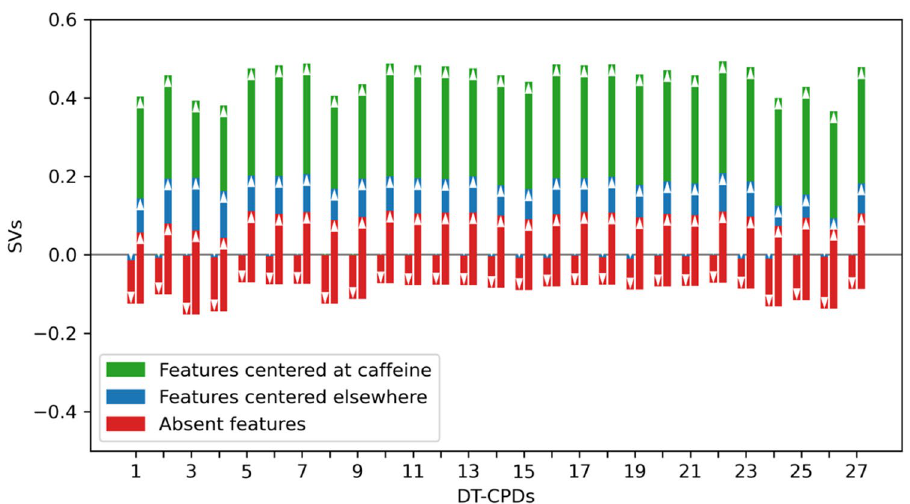
Figure 7. Contributions of caffeine-delineating features and others. For caffeine-containing DT-CPDs, cumulative SV contributions of features defining the caffeine moiety (green), features mapping elsewhere in the compound (blue), and absent features (red) are reported. The height of each bar accounts for the sum of feature SVs per